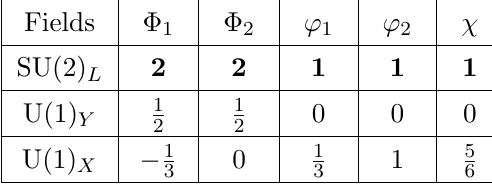
Table 2 . Scalar (cid:12)elds and extra fermion (cid:31) in the minimal model and their representation